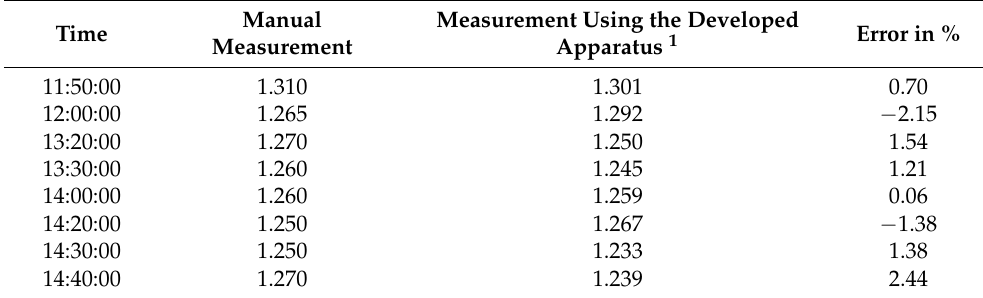
Table 3. The results of the density measurements using the manual method and the comparison with the results obtained from the apparatus (hydraulic densimeter).